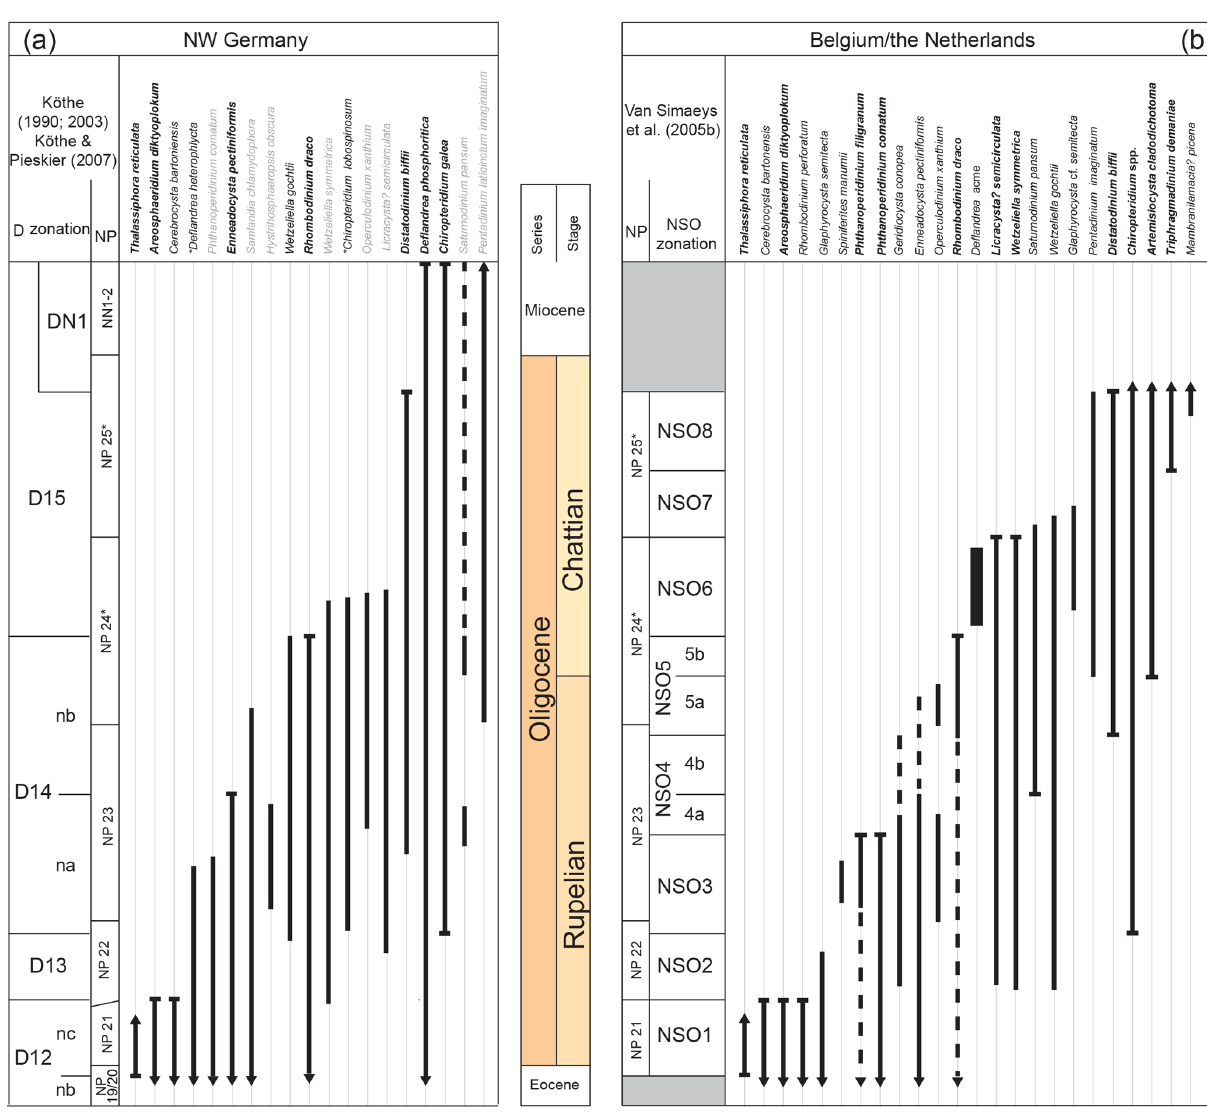
Figure 7. Dinoflagellate zonations used in the present study. Figure modified from ´Sliwi´nska et al. (2012). (a) The D zonation (Köthe 1990, 2003; Köthe and Piesker, 2007): bold italics – index marker of Köthe (2003), italics – additional marker proposed by Köthe (2003), grey – further species introduced by Köthe and Piesker (2007), ∗ – range of an additional marker modified by Köthe and Piesker (2007). (b) The NSO zonation of Van Simaeys et al. (2005b): bold italics – index marker, italics – additional marker. The original calibrations with calcareous nannofossil zonation are shown for each zonation. Because of the use of substitute markers for defining the base of NP24 and NP25, these two zones in northwestern Germany, Belgium and the Netherlands are marked with an